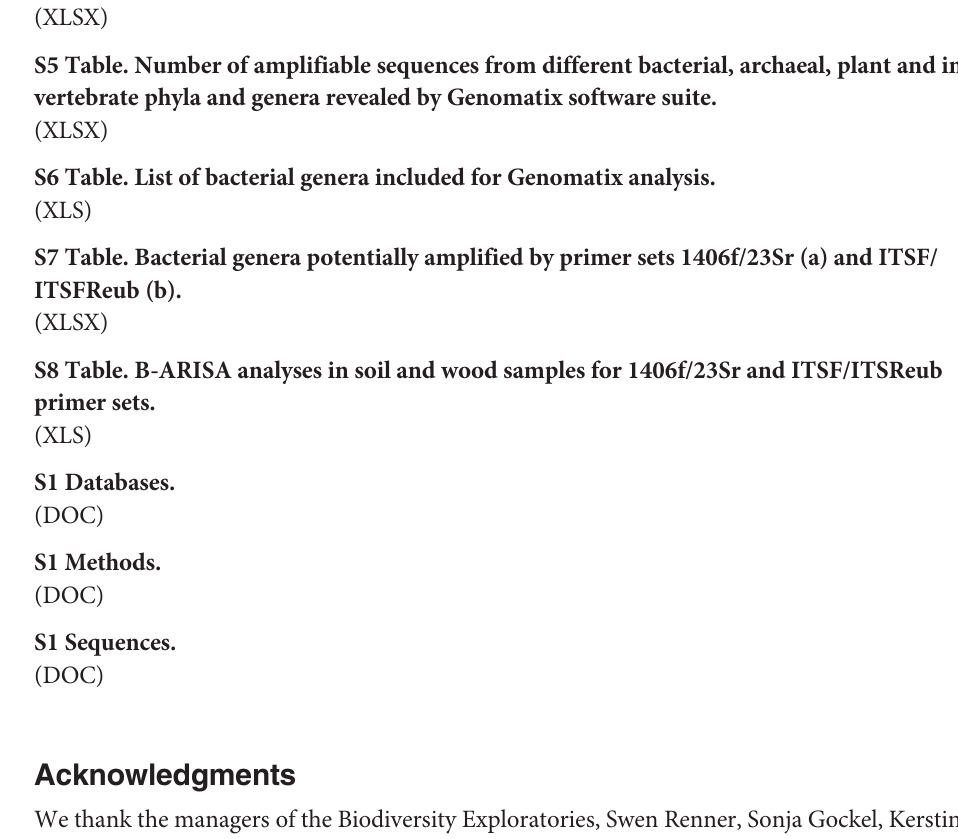
S1 Table. Number of species with positive virtual amplification for different prokaryotic phyla in the embl-pro database (41 phyla, 1200281 sequences) revealed by ecoPCR. S2 Table. Number of species with positive virtual amplification for different bacterial phyla in ncbi-bac-spacer database (19 phyla, 37134 sequences) revealed by ecoPCR. S3 Table. Number of amplified sequences for different prokaryotic phyla in wgs-embl-pro database (21 phyla, 178462 sequences) revealed by ecoPCR. S4 Table. Non-target species amplifiable by the different primer sets. Table shows the poten- tial ability of primer sets to amplify mitochondrial, chloroplast, fungal, plant and invertebrate sequences. S5 Table. Number of amplifiable sequences from different bacterial, archaeal, plant and in- vertebrate phyla and genera revealed by Genomatix software suite. S6 Table. List of bacterial genera included for Genomatix analysis. S7 Table. Bacterial genera potentially amplified by primer sets 1406f/23Sr (a) and ITSF/ ITSFReub (b). S8 Table. B-ARISA analyses in soil and wood samples for 1406f/23Sr and ITSF/ITSReub primer